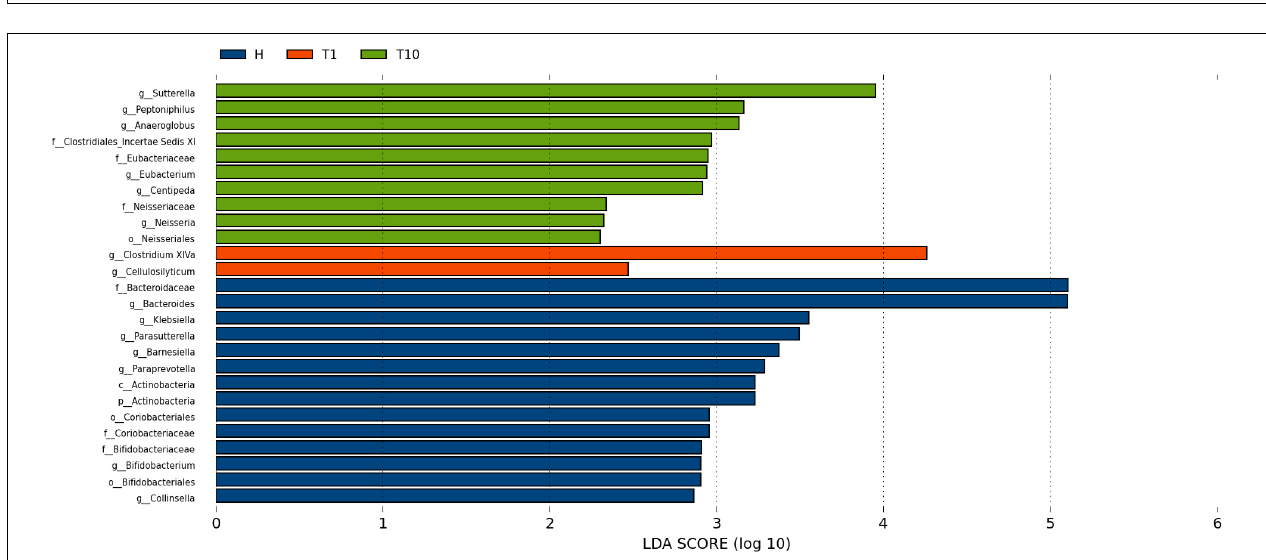
(2017), and Zhuang et al. (2019) found that patients with lung cancer in fecal microbiome showed elevated levels of Enterococcus, which could lead to increased DNA mismatch rate